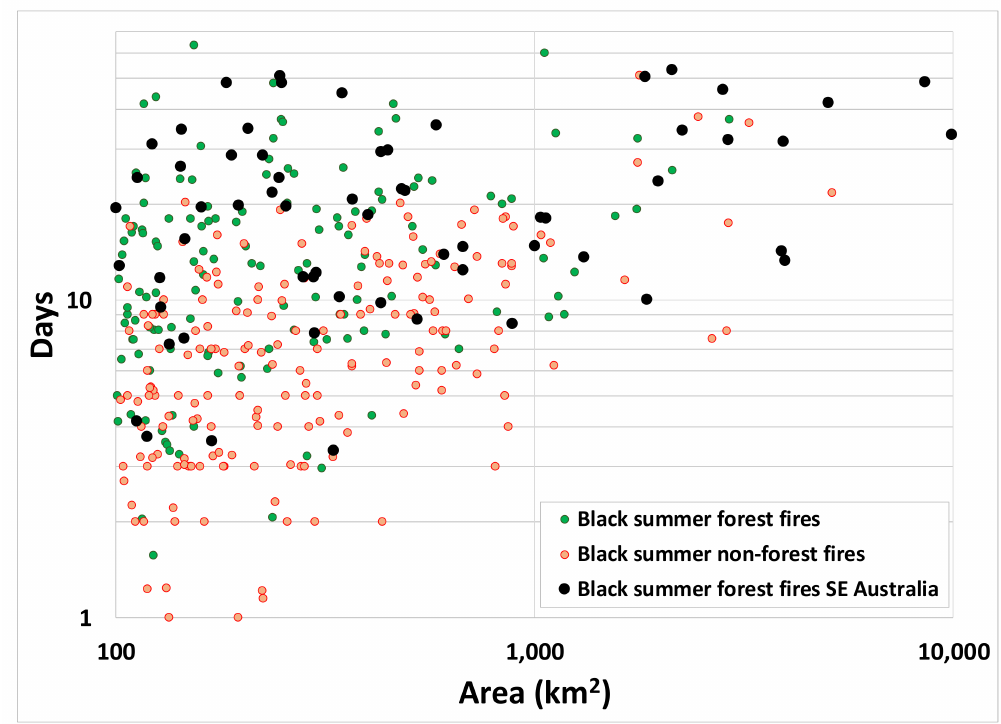
Figure 3. Two of the response variables of the wildfires included in this study: burnt area, and days the fires burned. Each point represents a single wildfire; the wildfires of the Black Summer are classified into forest and non-forest based on their pre-fire tree cover: above 40% (forest) and below 40%